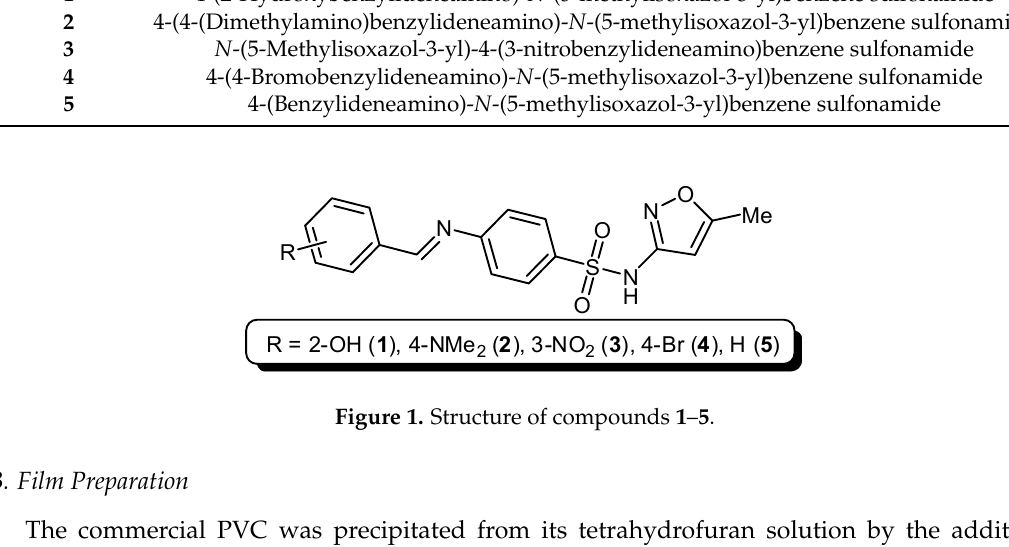
Table 1. Structure of Schiff’s bases 1 – 5 used as additives along with poly(vinyl chloride) (PVC). Compound